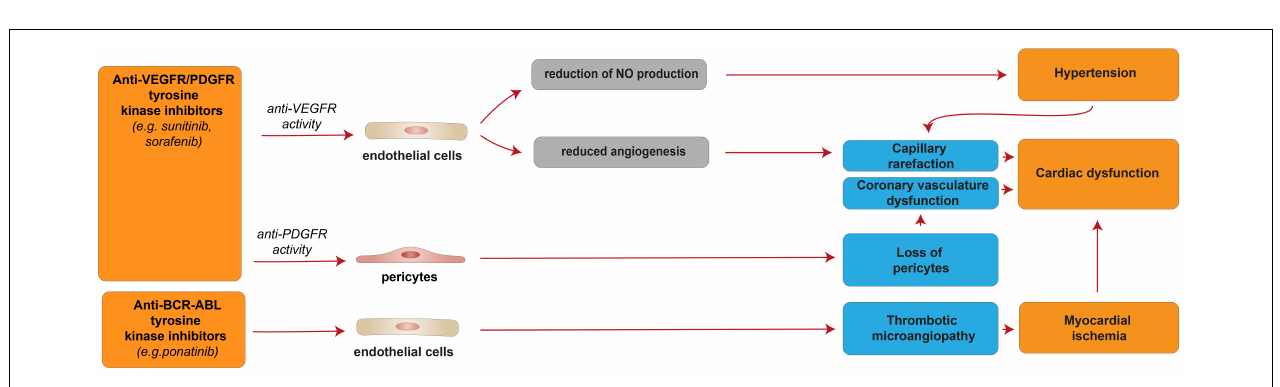
FIGURE 5 | Cellular and molecular mechanisms of the cardiotoxic effect exerted by ERBB targeting monoclonal antibodies and tyrosine kinase inhibitors. Schematic diagram showing the impact of ERBB targeting therapies on cardiomyocyte dysfunction caused by the impairment of Neuregulin-1 signaling. However, in combination with anthracyclines, anti-HER2 monoclonal antibody trastuzumab may also induce heart failure as a consequence of cardiomyocyte death induced by ROS accumulation.